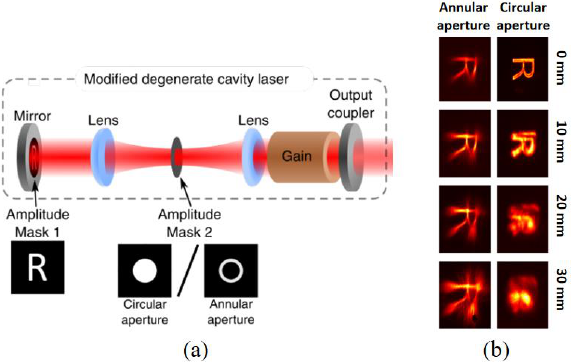
Figure 10. ( a ) Schematic of the degenerate laser with an aperture of different shapes; ( b ) The measured intensity profiles after different propagation distances (Adapted from an open-access source Ref. [89]).